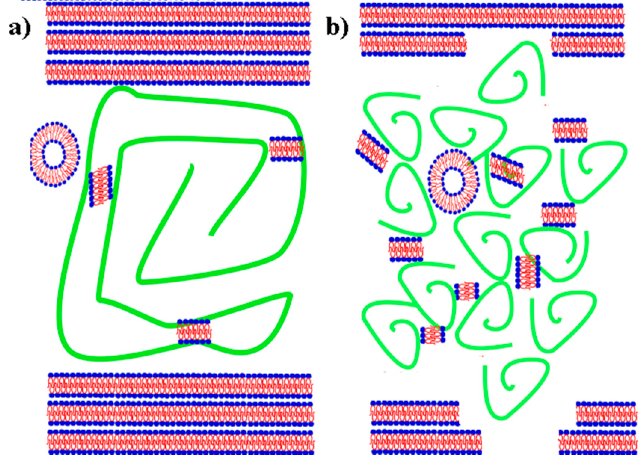
Figure 1. Artistic depiction of a model synovial joint organ system. The articular cartilage surface is represented as multilamellar bilayers of the SAPL without the underlying cartilage zones. Between the articulating surfaces, liposomal and lamellar phases are shown interacting with hyaluronan (A-) presented as molecular chains (green) in various states of cross-linking and network formation. Normal system conditions (of gel type) with an intact SAPL and long chain hyaluronan molecules ( a ) and pathological system conditions (of sol type) with a disrupted SAPL and broken hyaluronan molecules ( b ) are depicted.